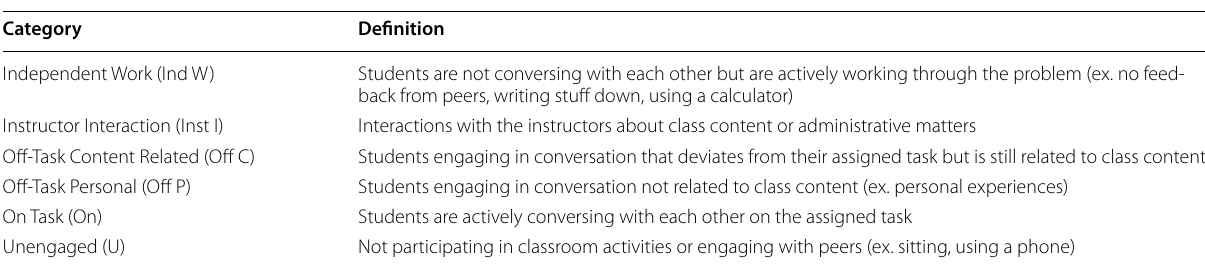
Table 1 Definitions of student interaction discourse moves type of interaction codes. Abbreviations of each discourse move are in parenthesis next to the name of the code